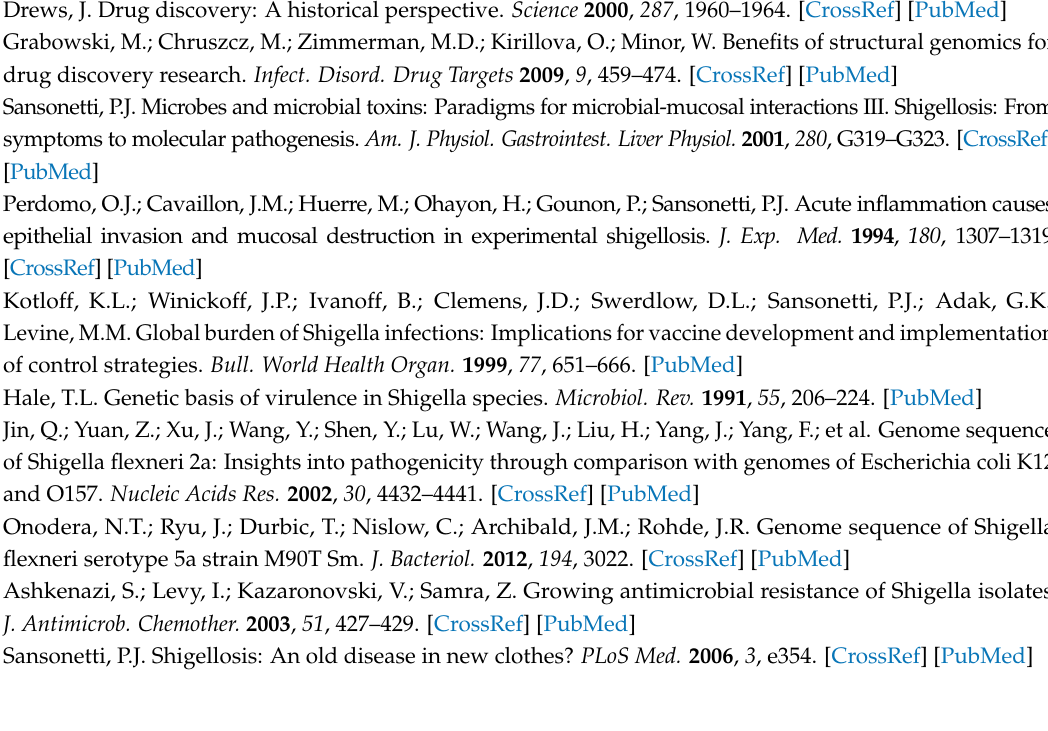
Supplementary Materials: The following are available online at www.mdpi.com/xxx/s1. Table S1: Summary Figure S2: Positions of conserved residues in the SF173 structure; Figure S3: Interchain electrostatic interactions in the SF173 structure; Figure S4: Structural homology of